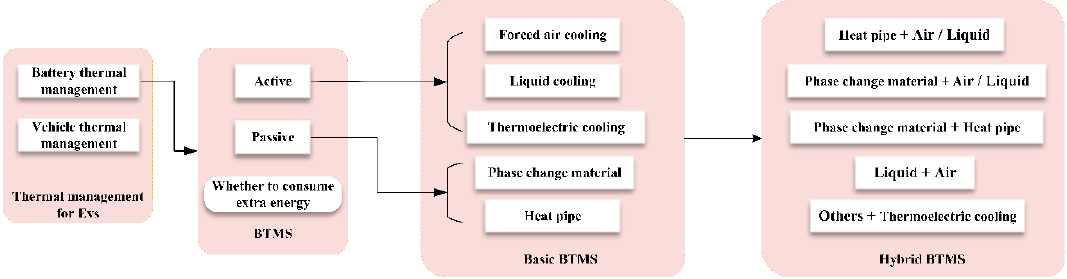
Figure 1. Classification of battery thermal management systems (BTMS).